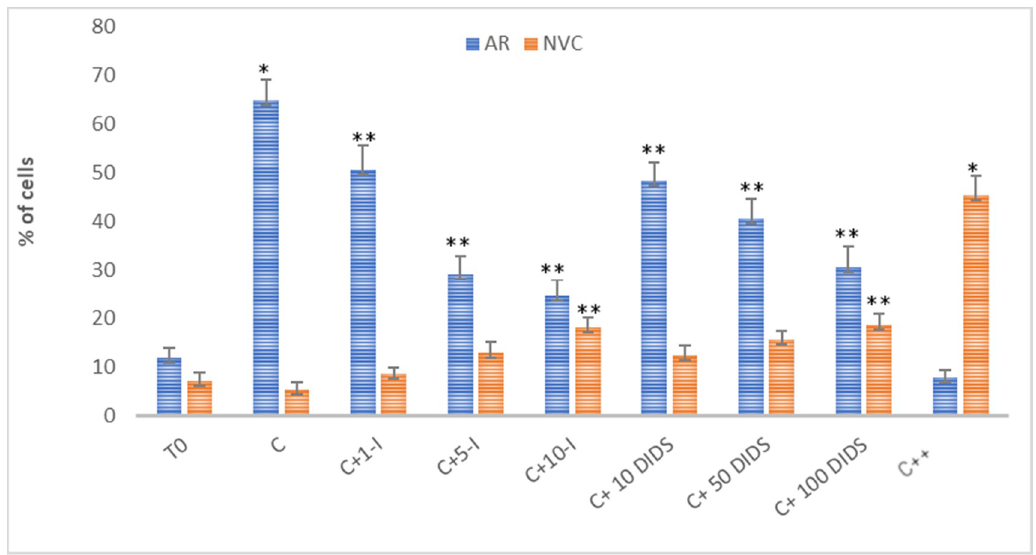
Figure 1. Effect of I-172 and DIDS on sperm capacitation and viability. Acrosome reaction induced by calcium ionophore A23187 and viability assay (tested with PI) at (T0) or incubated for 120 min in the absence (C) or presence of I-172 1, 5, 10 µM (C+1-I, C+5-I, C+10-I, respectively) or DIDS 10, 50, 100 µM (C+10 DIDS, C+50 DIDS, C+100 DIDS, respectively) or both (5 µM I-172 and 100 µM DIDS) (C++) were performed as described in Methods. Percentages of acrosome reacted cells (ARC%) and not viable cells (NVC%) were determined by immunofluorescence (see Methods). Comparison to both T0 and C was performed. Values represent the means ± S.D. of at least 8 experiments. For C compared to T0. *, p < 0.001; others compared to C, ** p < 0.05.